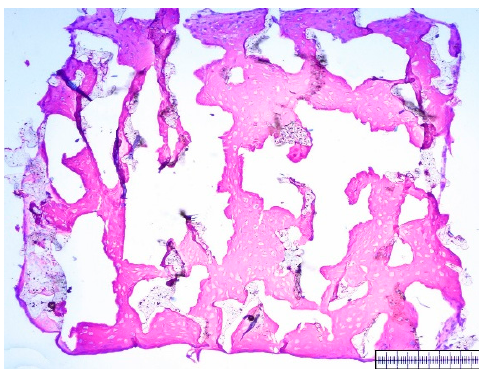
Figure 7. Representative slide of a hyaluronic acid gelatin composite scaffold after 21 days of in vitro chondrogenesis. Collagen type I immunohistochemistry. Collagen type I-rich areas appear black. Magnification bar = 500 μ m.